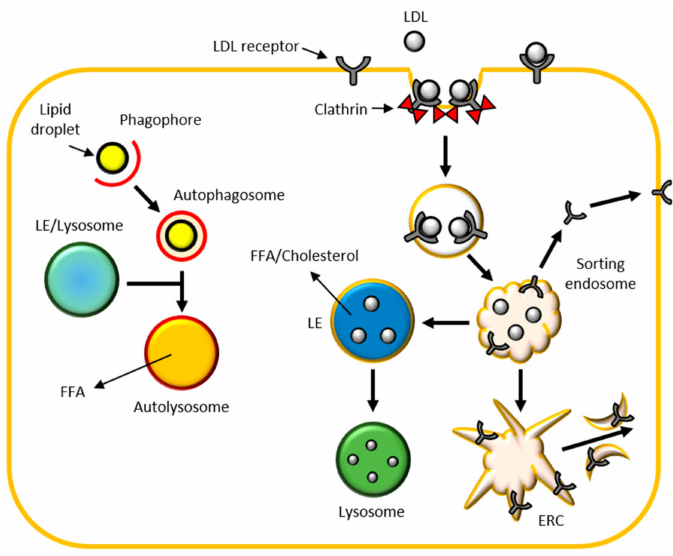
Figure 4. Lipid metabolism: lipid species such as triacylglycerols and sterol esters reach lysosomes (green) through different ways: as lipid bilayer of different vesicles; by endocytosis mediated by specific low-density lipoprotein (LDL) receptors; by autophagy specific for lipids (like lipid droplets), named lipophagy. LE, late endosome (blue); ERC, endocytic recycling compartment (light yellow); FFA, free fatty